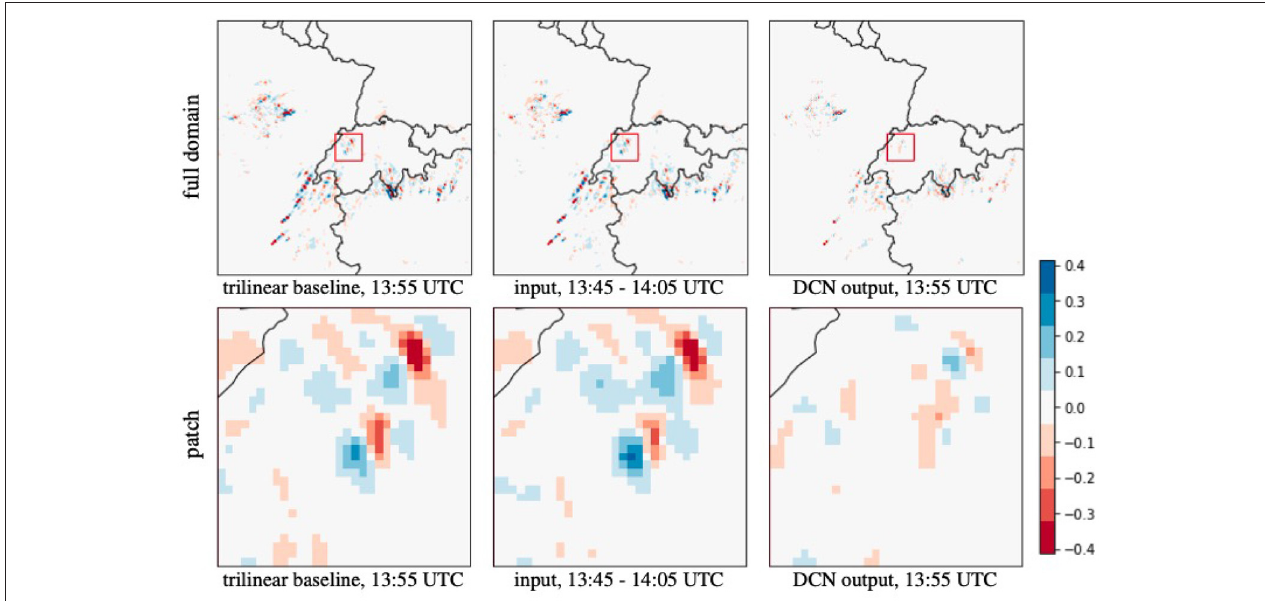
FIGURE 7 | The error map of Figure 6 compares the trilinear interpolated baseline, the time-integrated network input covering the time to predict, and our predicted output. DCN reduces the MSE from 2.269 to 0.745 g/m 2 on the full domain, and from 4.531 to 0.910 g/m 2 in the shown patch.